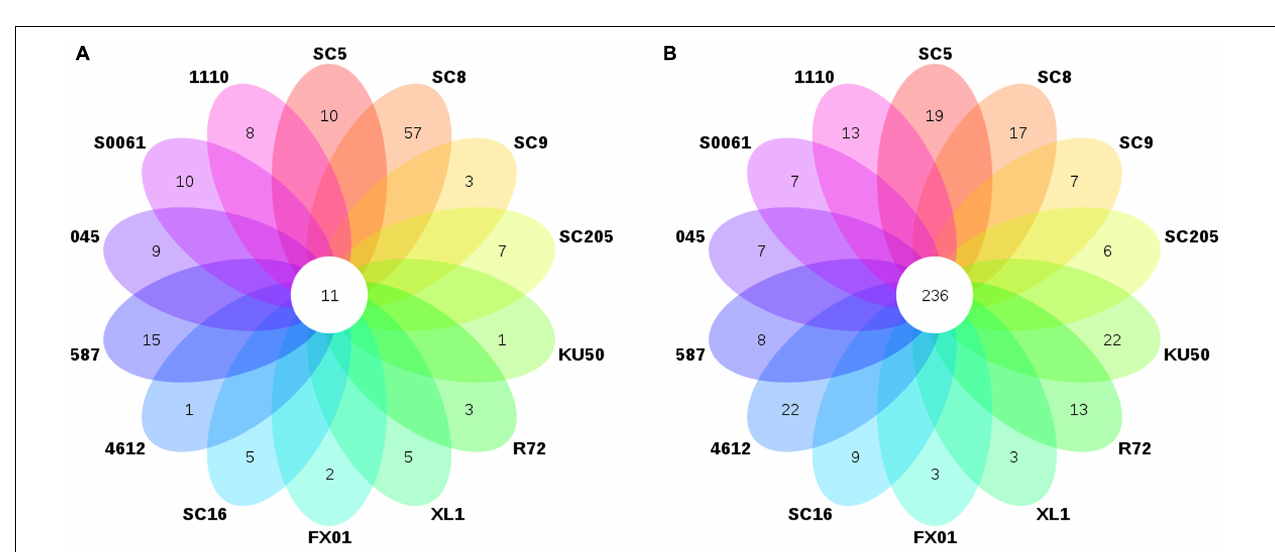
FIGURE 2 | Heatmap of the relative abundances at the genus level of the TOP 50 bacterial communities in (A) the tuberous roots and (B) the rhizosphere soil of different cassava genotypes.